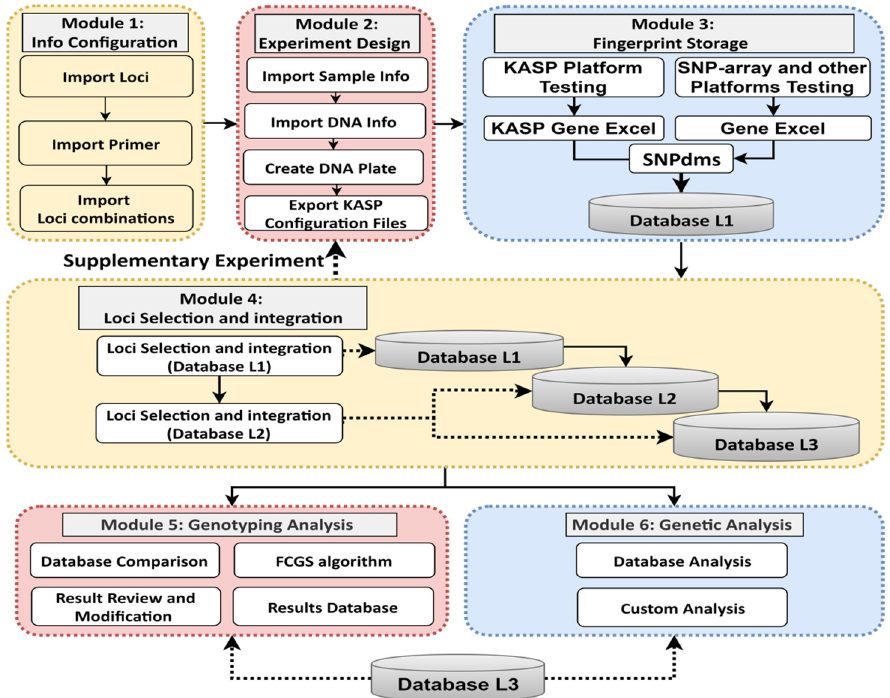
Figure 3. Modular structure of PSNPdms, including the workflow between the main modules and functions. PSNPdms includes multi-level fingerprint libraries and the data transfer relationships between them. Problems encountered during data filtering and integration can be solved by performing supplemental experiments or correcting the fingerprint data, which increases the efficiency of the data transfer process, thus making experimentation and data analysis a closed-loop process.